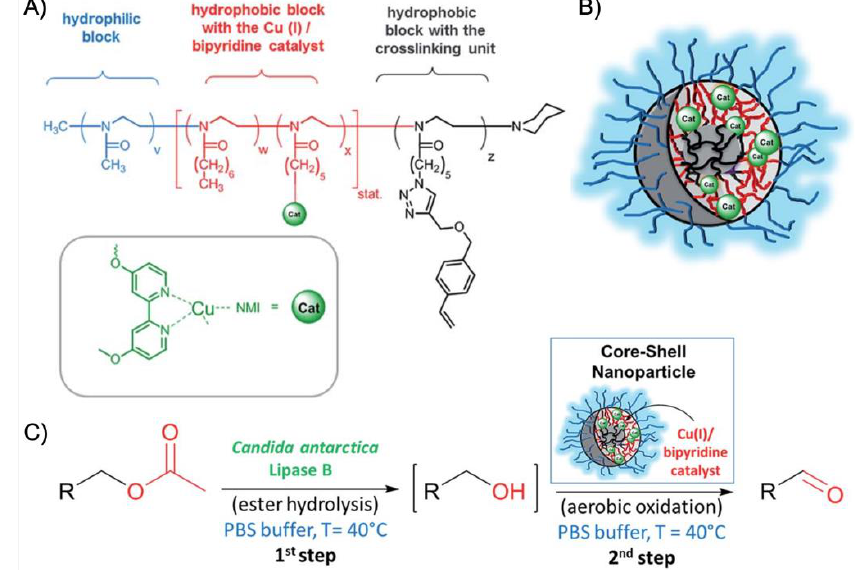
Figure 9. Chemoenzymatic cascade reaction of BCP metal catalyst and enzyme-immobilized polymer beads. ( A ) Chemical structure of the ABC triblock terpolymer. ( B ) Formation of core-cross-linked core-shell NPs with Cu/bpy metal catalyst by microemulsion. ( C ) Two-step cascade reaction of ester cleavage and oxidation for the transformation of esters to aldehydes. Adapted with permission of [118]. Copyright 2017 Royal Society of Chemistry.